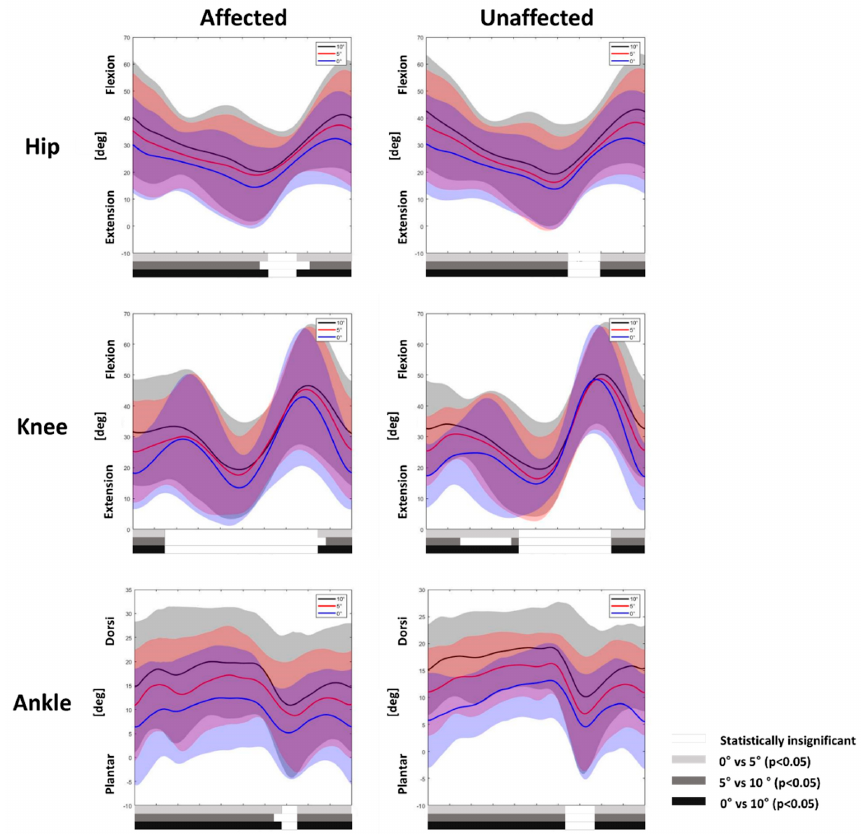
Figure 2. Joint kinematics of the hip, knee, and ankle joints of the affected and unaffected legs during uphill gait. Mean kinetic angles were plotted for 0 ◦ (blue), 5 ◦ (red), and 10 ◦ (black), and the shaded areas indicate ± 1 standard deviation. Statistically significant differences are represented by bars below the curves analyzed by statistical parametric mapping; 0 ◦ vs. 5 ◦ (light gray bars), 5 ◦ vs. 10 ◦ (gray bars), and 0 ◦ vs. 10 ◦ (black bars). Statistically significant differences between incline gaits are represented by the white bars. Table 3. Results of temporospatial parameters for both limbs during downhill